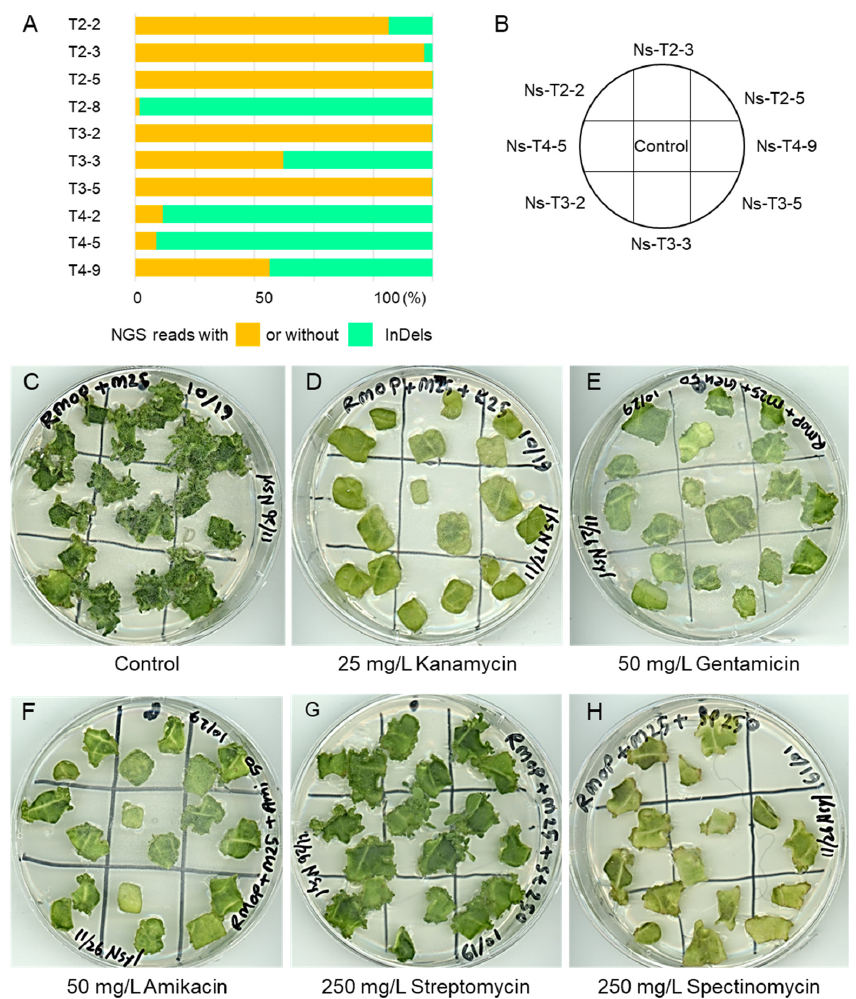
Figure 4. Evaluation of aminoglycoside antibiotic resistance in tissue culture of T 0 generation of N. sylvestris . ( A ), bar graphs showing the ratio of NGS reads with or without InDels at the target sites in the selected transgenic lines. ( B – H ), control and some selected transgenic plants were evaluated for their aminoglycoside resistance as described in the caption for Figure 3.